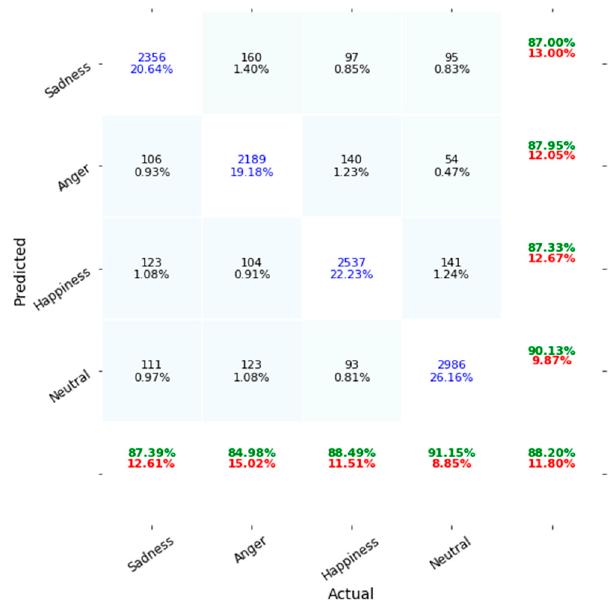
Figure 6. Accuracy of the training and validation for the multi-class classification and recognition application.